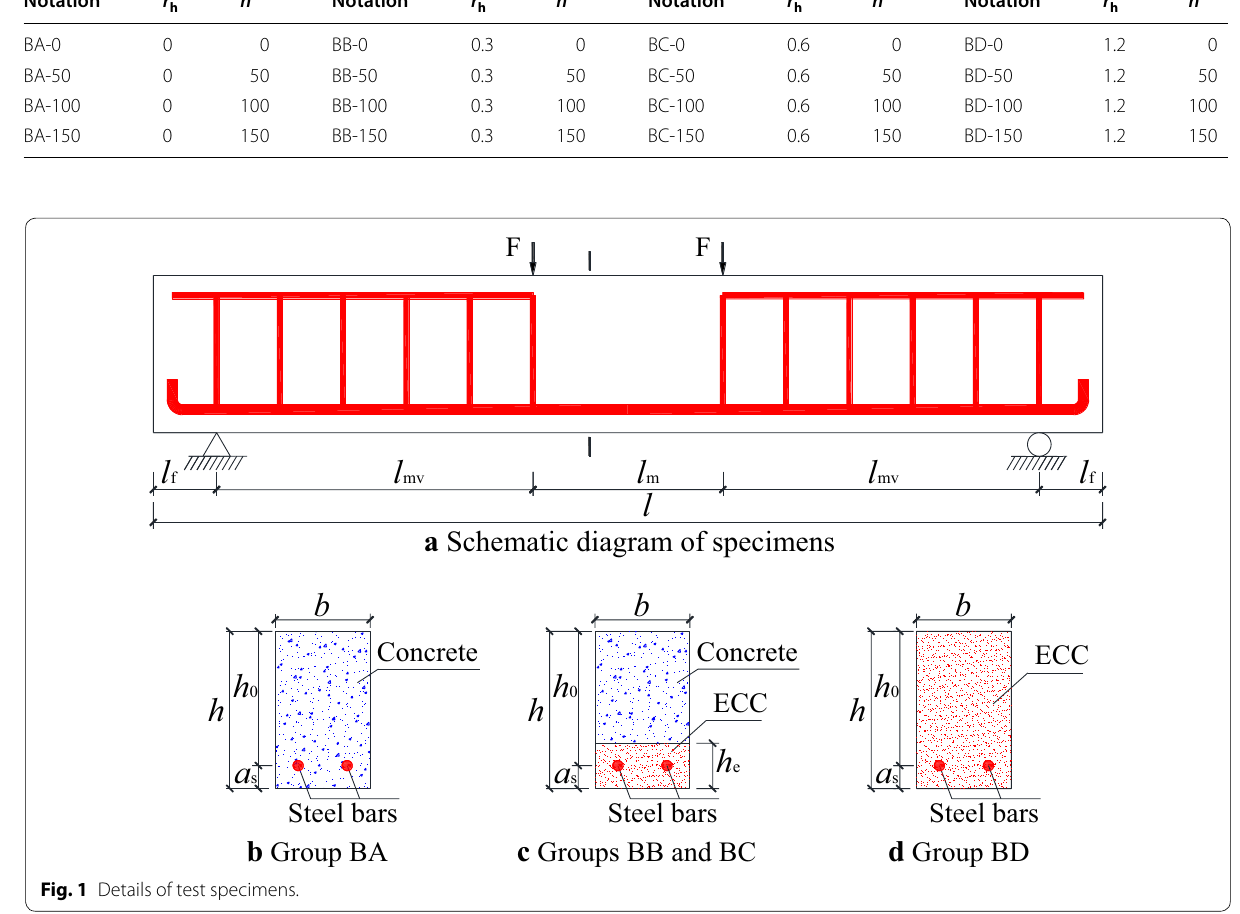
Fig. 1 Details of test